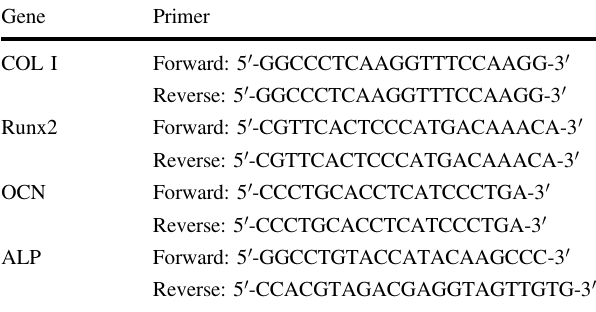
Table 1 The sequence of analyzed gene primer for real-time PCR